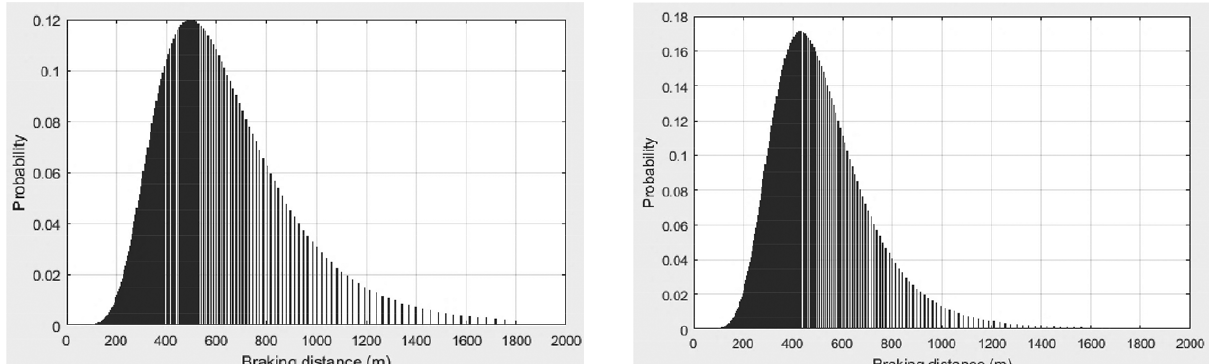
Figure 5. Simulated braking distance probability distribution in 100 mm/h violent rain and 1 mm MTD for transverse slopes of (a) 0.5%, and (b) 2.5%